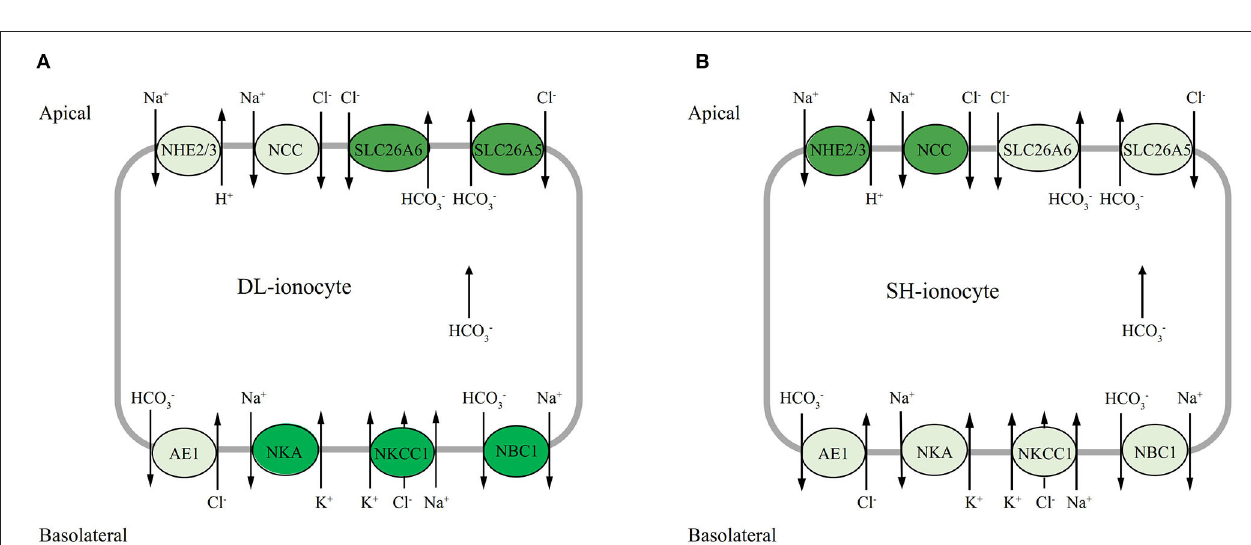
FIGURE 8 | Hypothetical model of mRNA expression of each gene in the gills of DL (the alkali form introduced from Lake Dali Nor) and SH (the freshwater form introduced from Songhua River) fish forms in 50mM alkaline water. The dark background denotes upregulated expression, whereas the light background denotes downregulated